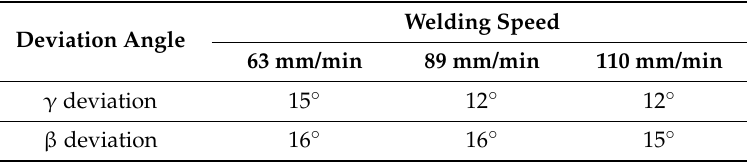
Table 4. γ and β deviation for different welding speed.